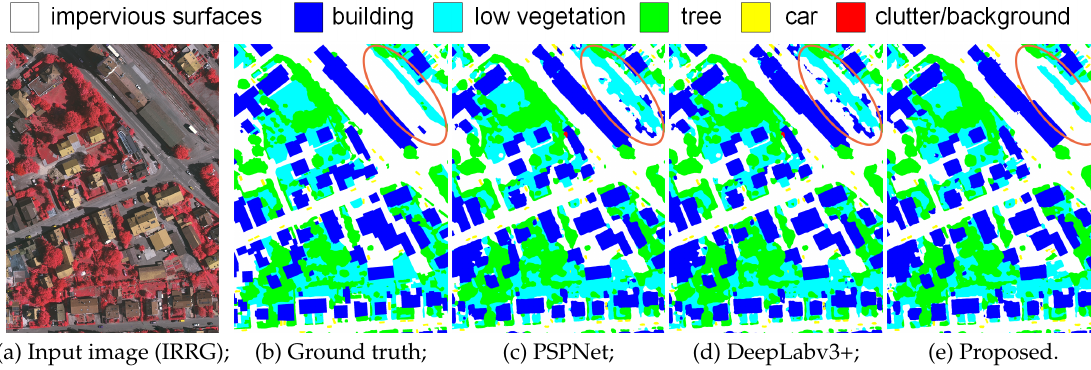
Figure 11. Classification maps produced by the compared approaches on the Vaihingen dataset. Major differences are highlighted (zoom in to see more